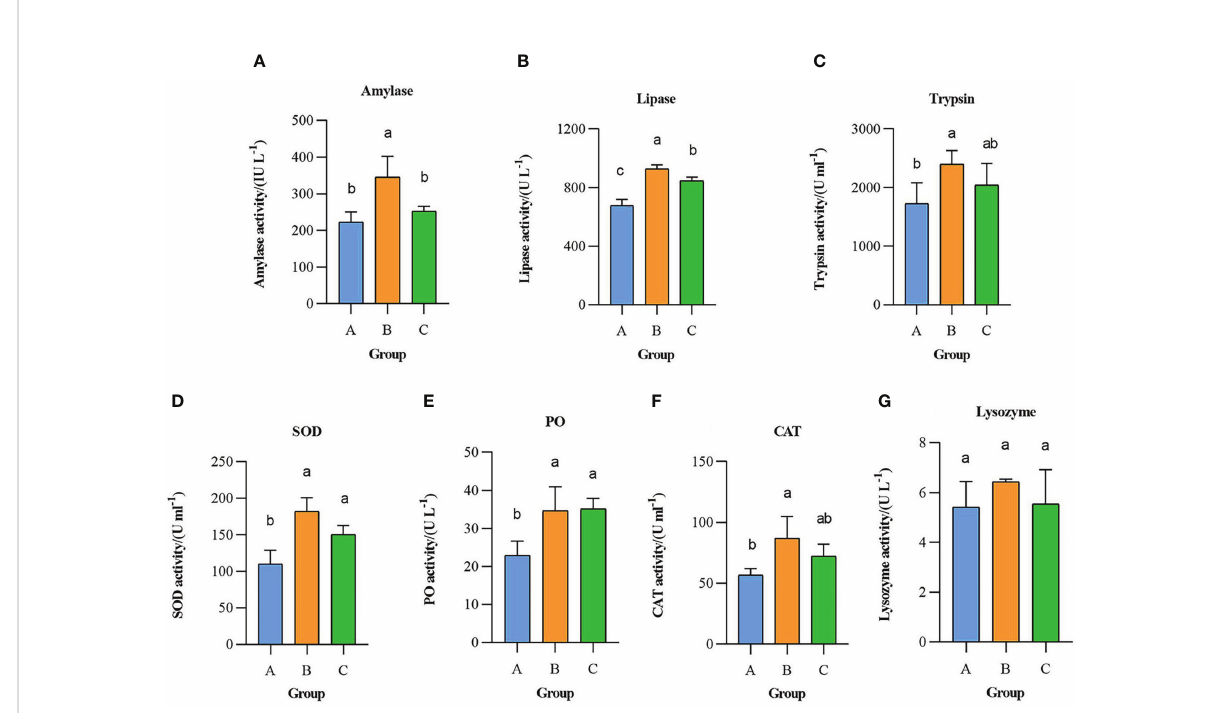
FIGURE 2 Effects of sodium humate (B) and sodium humate with Probiotics (C) on intestinal amylase (A) , lipase (b), trypsin (C) and hepatopancreas SOD (D) , PO (E) , CAT (F) and lysozyme (G) of L. vannamei . Upright bars denote the mean ± SD (n = 6). Bars labelled with different letters denote signi fi cant differences ( p < 0.05) between the experimental groups.